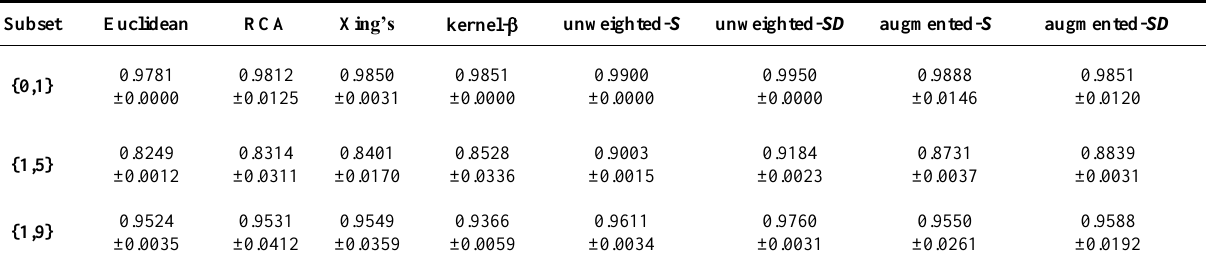
Table 3. Clustering results on three subsets of the MNIST